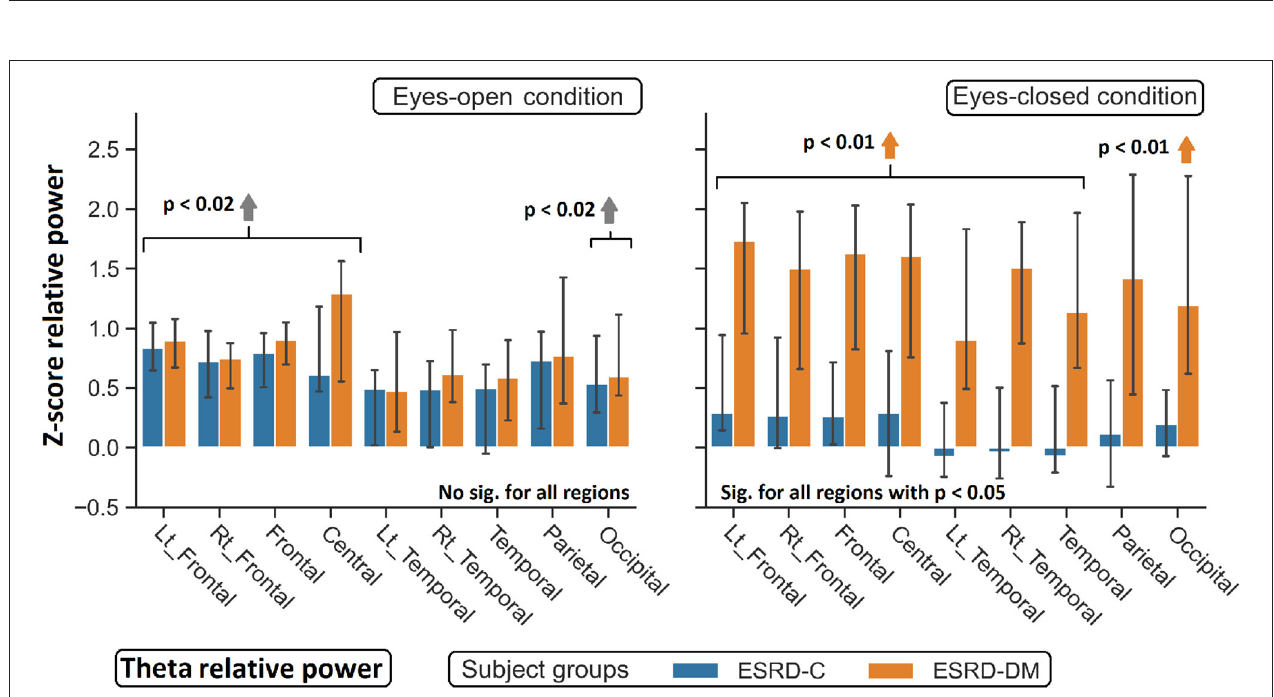
FIGURE 5 | Z-scores of theta relative power in nine topographical regions show significant difference between eyes-closed ESRD-C and ESRD-DM. Comparing to healthy control, higher theta was observed in both subject groups in some regions (gray arrow). Higher theta in eyes-closed ESRD-DM was also found in most regions (orange arrows). P -values were calculated by Mann–Whitney U -test. The whisker indicates 95 percent confident intervals with median as an estimator.